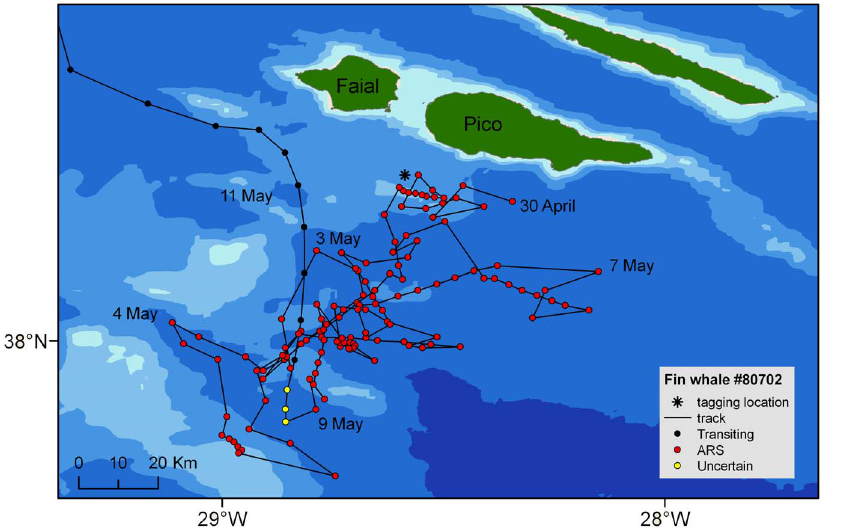
Figure 4. Example of the movements and behaviour of fin whales in the Azores in 2009–2011. Whale # 80702 was tagged on April 30 2010 (tagging location shown by a star) and departed on 11 May 2010. The track shows the inshore-offshore movement pattern south of the islands of Faial and Pico and along the shallow banks where the whale was in ARS for 12 days, and the clear behavioural switch associated with the north/ northwest trajectory as it resumed